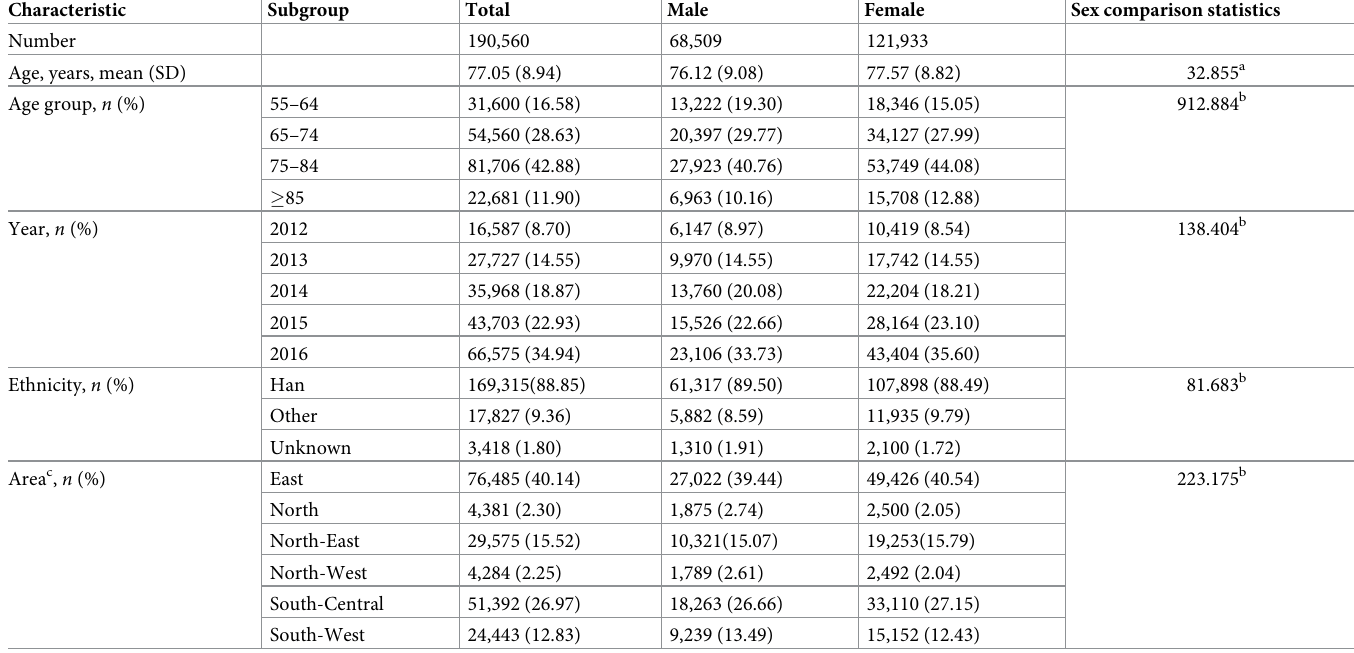
Table 1. Selected characteristics for hip fracture patients grouped by sex.